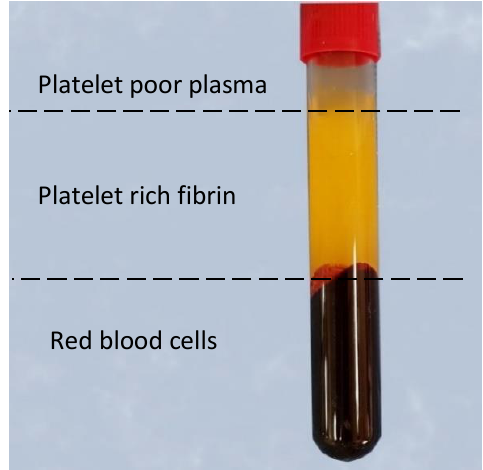
Figure 1: layers after blood centrifugation Using tweezers gently the PRF were pulled out and placed in a sterile wet gauze mesh, scraping the bulk of RBC layer carefully by surgical scalpel leaving the buffy coat intact (Fig. 2)